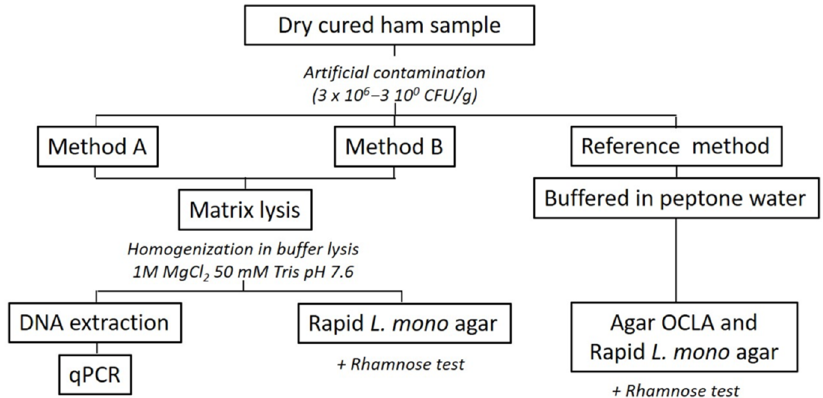
Figure 1. Scheme of the L. monocytogenes quantification methods steps. Method A